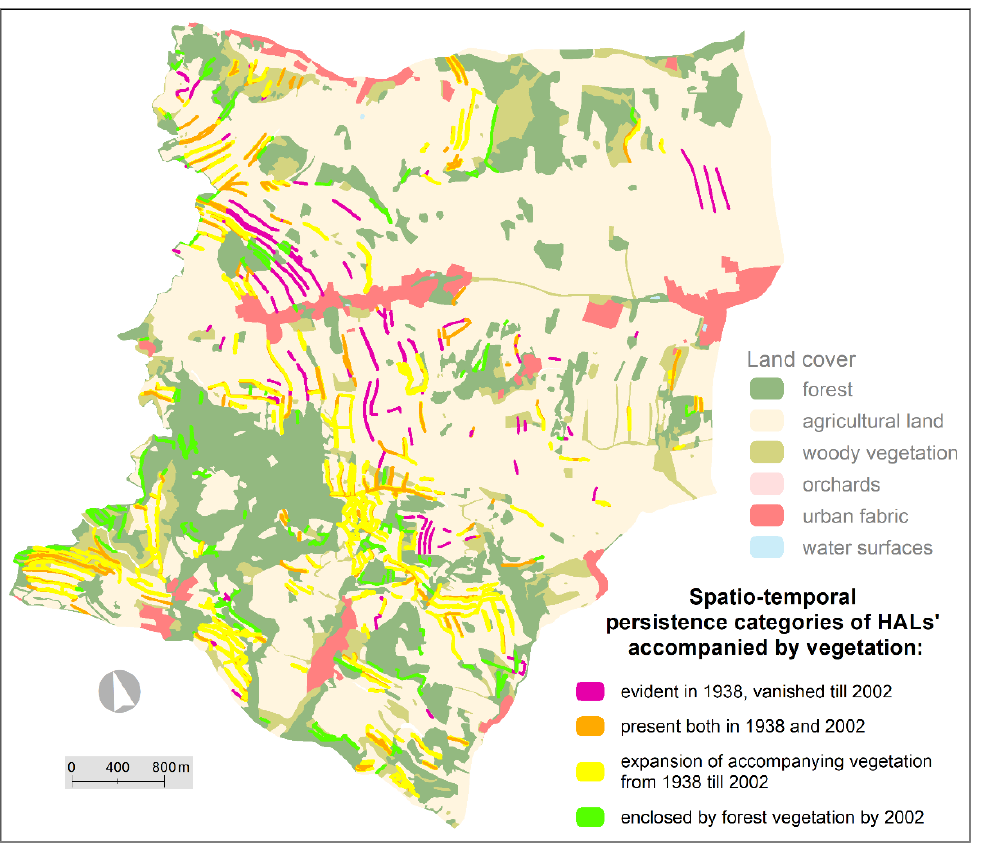
Figure 13. Spatial development of woody vegetation associated with HALs in the Verneřice region (České Středohoří Mts) between 1938 and 2002 [data sources: digitized dataset, processed in ArcGIS, ESRI, Redlands, CA, USA]. Table 1. Counts of Araneae and Carabidae species and their diversity and similarity measures in habitats studied at Milešov in the ˇCesk é Stˇredohoˇr í